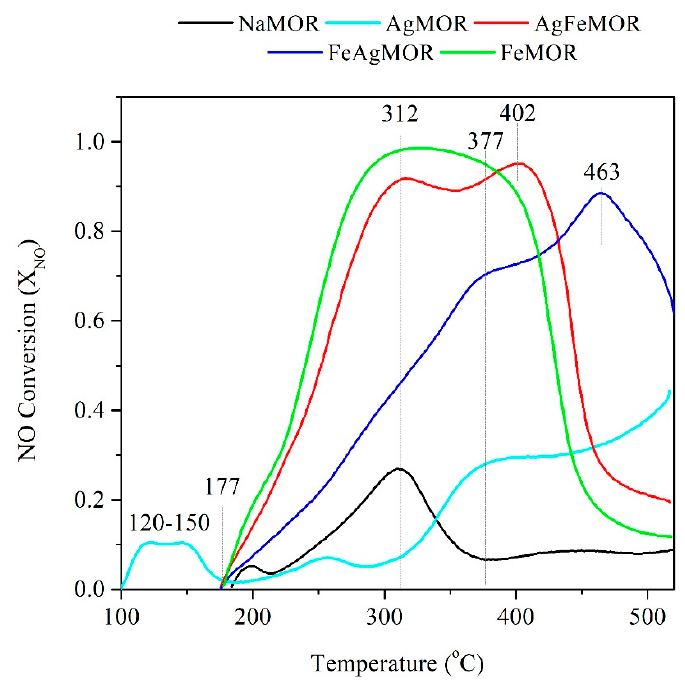
Figure 3. Results of the de-NO x catalytic test for the studied samples.